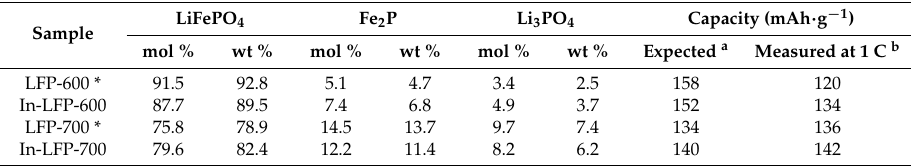
Table 3. Percentage of LiFePO 4 , Fe 2 P and Li 3 PO 4 in LFP and In-LFP samples annealed at 600 ◦ C and 700 ◦ C deduced from Mössbauer measurements.